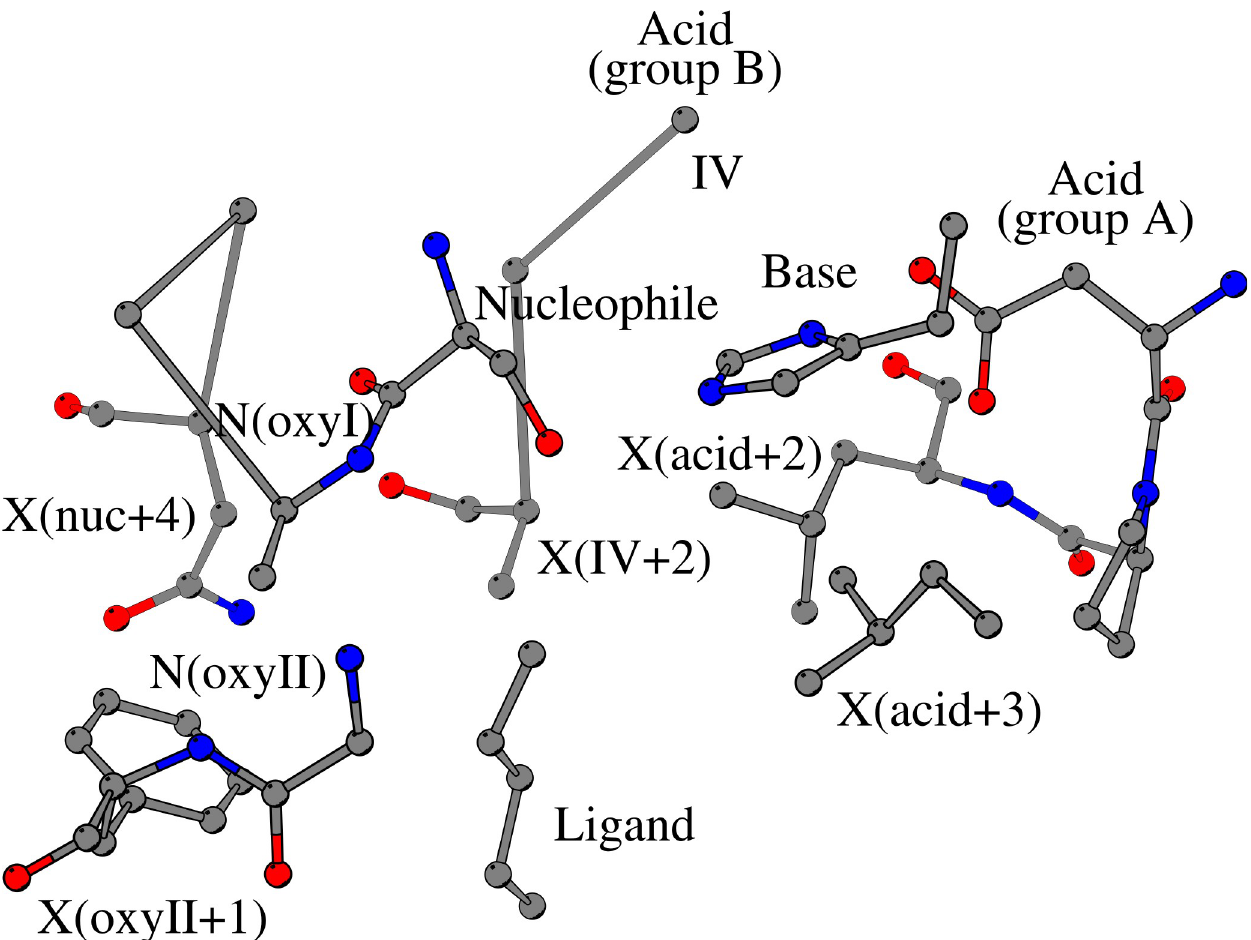
Fig 4. Structural elements at the active site of the ABH fold enzymes surround the bound ligand. Recognized substrate molecules (shown as “Ligand”) are bound to the active sites of ABH fold enzymes in order to be hydrolyzed. Key residues of the catalytic machinery, such as the catalytic histidine (“Base”), the catalytic nucleophile (“Nucleophile”) and the residues that help form the oxyanion hole (“oxyI” and “oxyII”) often interact with the bound substrate; the catalytic acid, either at its canonical position (at the turn that follows strand β 7, “Acid (group A)”) or at its alternate position (at the C-terminal end of strand β 6, “Acid (group B)”) does not participate in ligand binding. Several residues, which belong to the structural core of ABH fold enzymes, participate both in the coordination of the residues of the catalytic machinery and in ligand binding, including the residues that are located two and three sequence positions after the catalytic acid, illustrated as “X(acid+2)” and “X(acid+3)” respectively, and the residue at the C-terminus of strand β 6. Other residues, usually comprising the substrate binding core, are illustrated as “X(IV+2)” for the residue that is located two positions after the C-terminus of strand β 6, “X(oxyII +1)” for the residue that follows the second residue that helps form the oxyanion hole, and “X(nuc+4)” for the residue that is located four positions after the catalytic nucleophile.